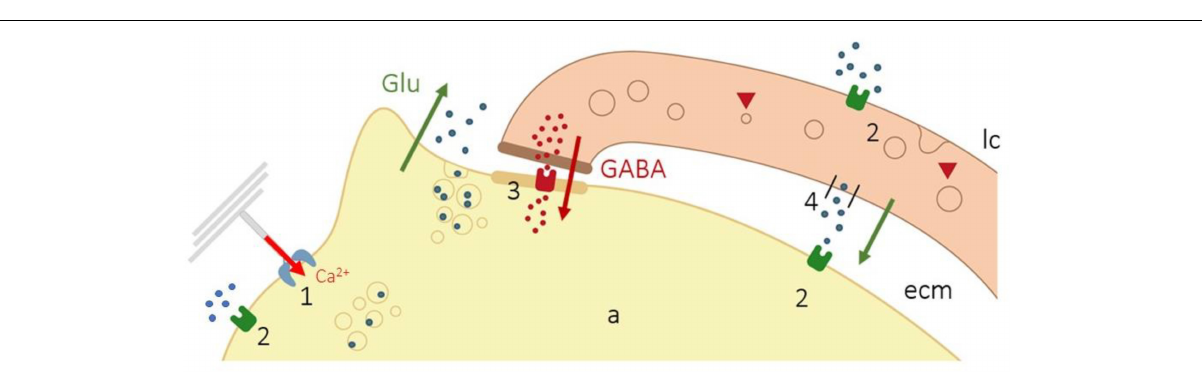
FIGURE 4 | Schematic representation of the synaptic-like coupling of the axon and lamellar cells in Pacinian corpuscles. Opening of mechano-gated channels (1) causes the entry of Ca 2 + in the axon (red arrow) and release of glutamate from clear-core vesicles of the axon (green arrow), which can act on the lamellar cells or the axon (2). Glutamate acting on lamellar cells induces GABA release (brown arrow), which activates GABA receptors in the axon (3) inhibiting glutamate excitation. In addition, the lamellar cells contain vesicular-glutamate transporters, and SNARE proteins, that consent glutamate release by the lamellar cells (4). Modified from Pawson et al.